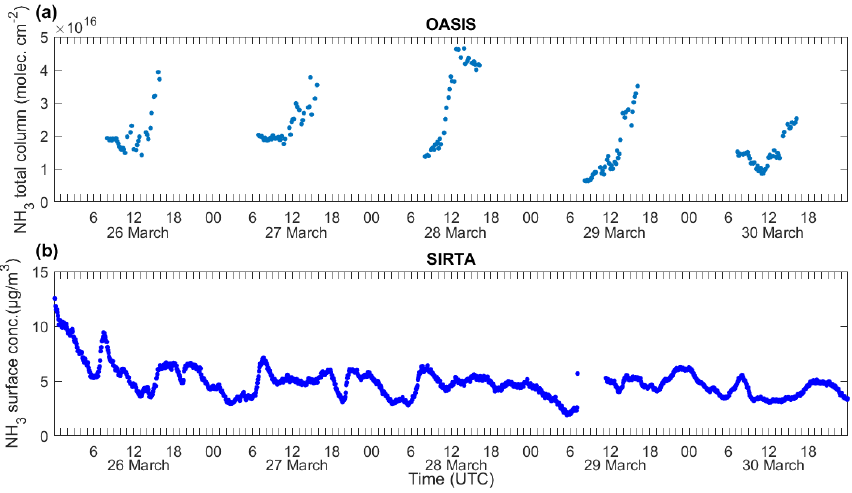
Figure 5. Observations of atmospheric ammoniac concentrations over the Paris region from 26 to 30 March 2012. The upper panel (a) dis- plays total column retrievals at Créteil derived from OASIS observatory (48.79 ◦ N, 2.44 ◦ E) measurements during the day ( ∼ 07:00 and 16:00UTC). The lower panel (b) displays continued ammonia surface concentration measurements from the AiRRmonia instrument near Palaiseau (SIRTA observatory; 48.71 ◦ N, 2.20 ◦ E). This figure shows all available individual measurements from OASIS FTIR instrument and AiRRmonia in situ